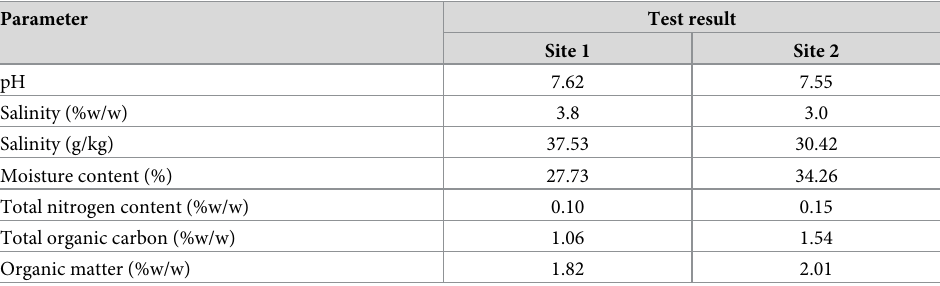
Table 1. Physicochemical analyses of soil